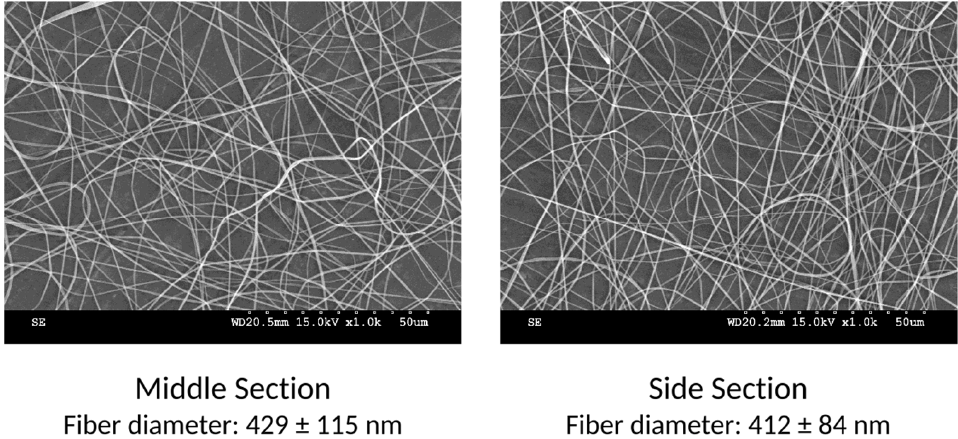
Figure 7. Example of the fibers from the middle and from the side with parallel plate auxiliary electrodes.